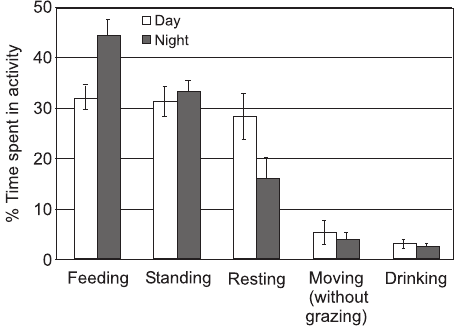
Fig. 2. Relative proportions of time allocated by the buffalo herds to activities, diurnal (white) and noc- turnal (black) components, with their standard errors ( SE ).